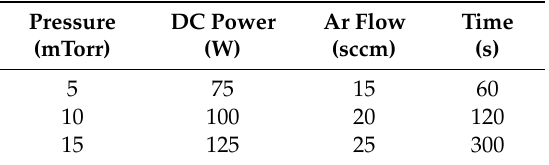
Table 1. Selected values of pulsed-DC reactive magnetron sputtering process’ selected for the optimization of aluminum films using L 9 (4 3 ) orthogonal table.